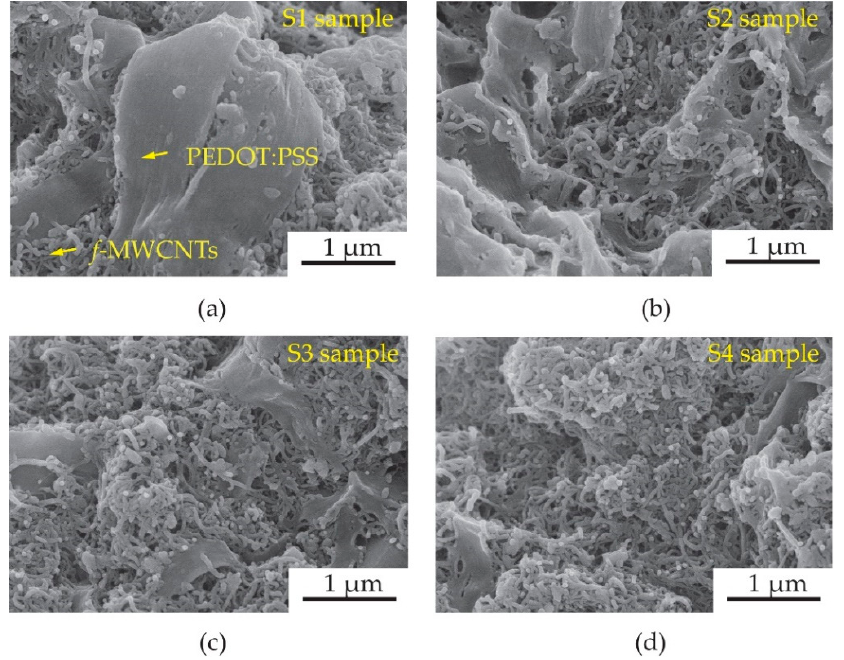
Figure 5. SEM images of f -MWCNTs embedded in PEDOT:PSS sensing-films at different samples of ( a ) S1, ( b ) S2, ( c ) S3 and ( d )